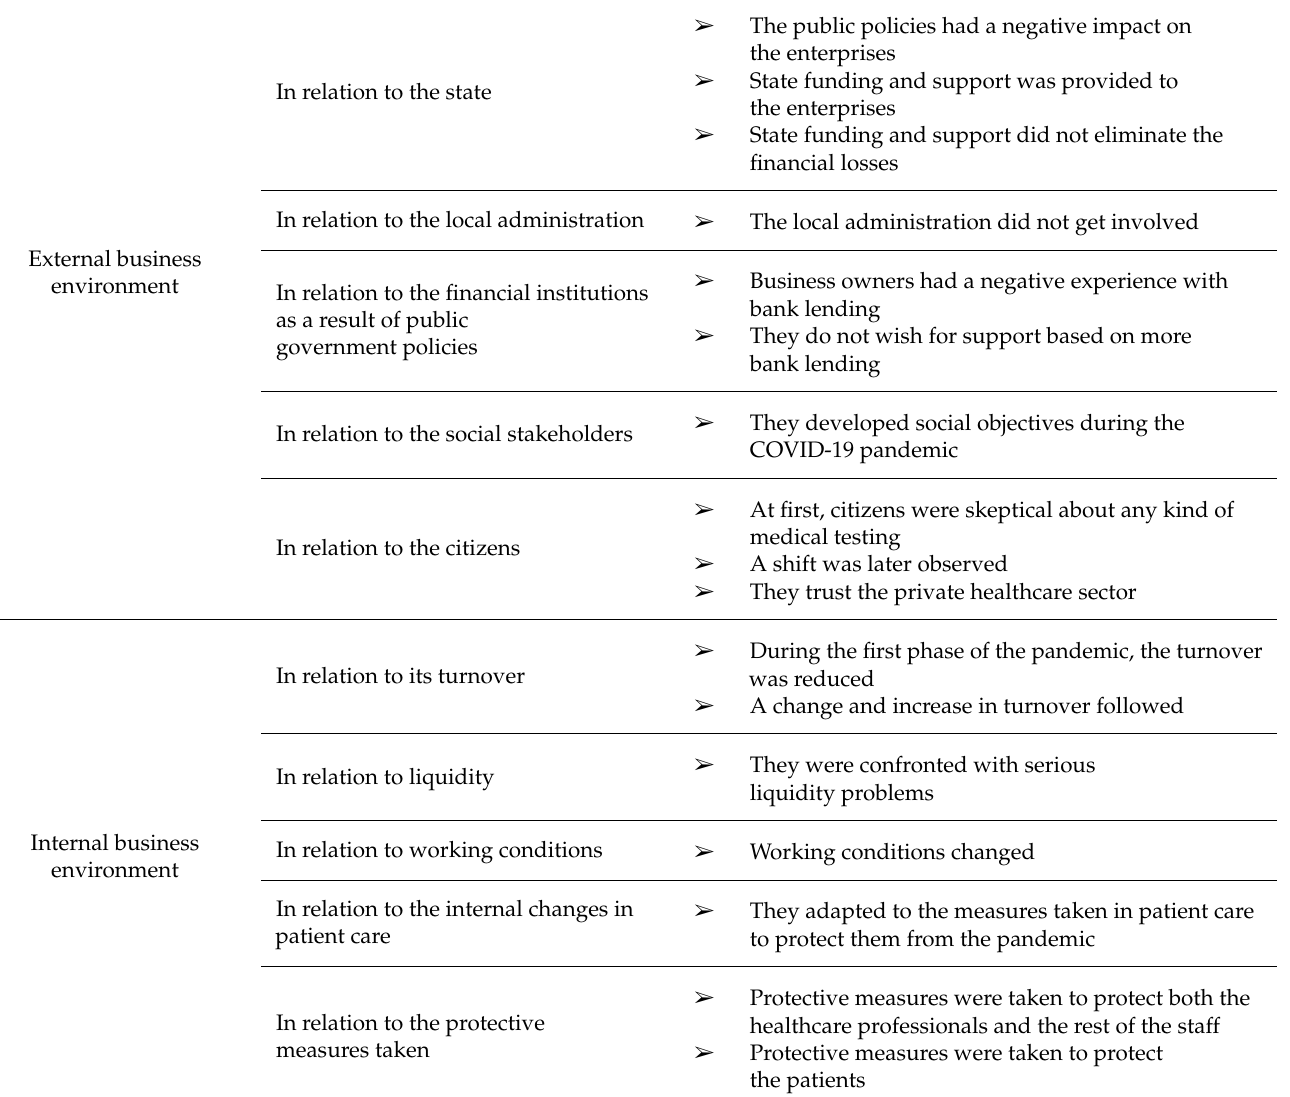
Table 2. Emerging